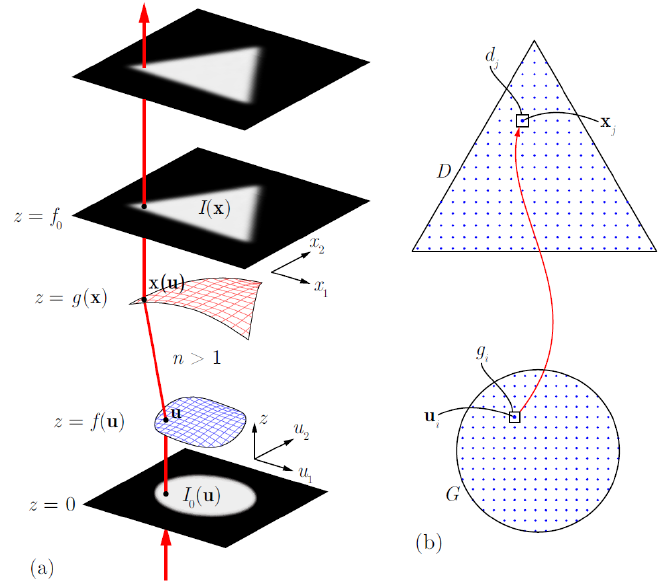
Figure 4. Geometry of the design problem of an optical element ( a ). Approximation of the circular area G and triangular area D by cells with equal streams ( b ) [103].